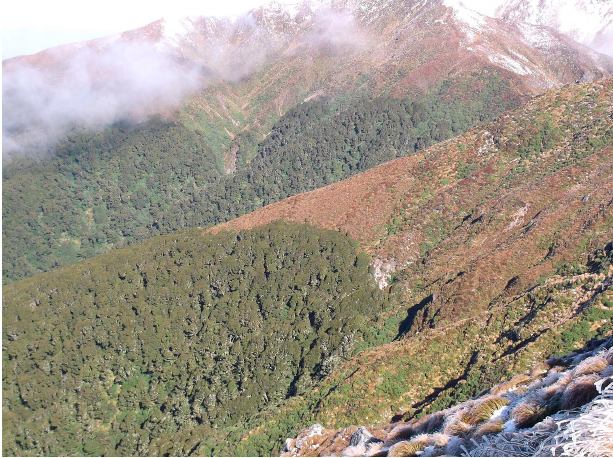
Figure 3. Upslope migration of tree lines represents a land cover change that affects turbulent exchange processes over mountains. © William Demchick.